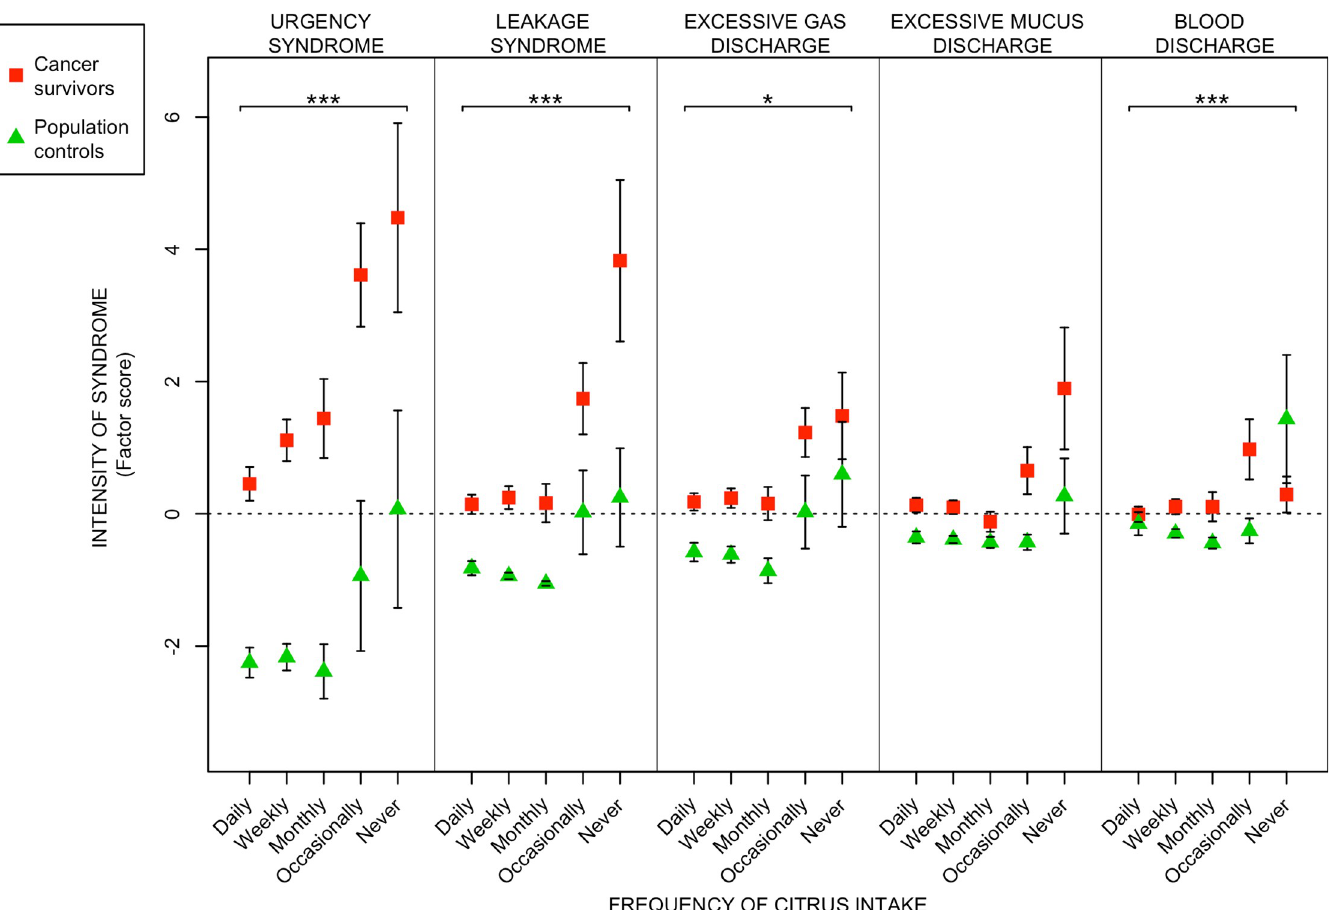
Fig 1. Relationships between radiation-induced survivorship syndromes and frequency of citrus intake. The figure depicts the relationships between frequency of citrus intake (x-axis) and intensities (factor scores) of the five radiation induced syndromes (y-axis: defecation-urgency syndrome, fecal-leakage syndrome, excessive gas discharge, excessive mucus discharge and blood discharge) among long-term gynecological cancer survivors and population controls. Red squares and green triangles denote the mean syndrome intensities within certain citrus intake frequency levels. Vertical black lines stretch between plus-minus the standard error of the mean. Asterisks correspond to significance levels of the Spearman correlations between syndrome intensities and frequency of citrus intake according to: p � 0.001 - ��� , 0.001 < p � 0.01 - �� . 0.01 < p � 0.05 - � . Estimates of the Spearman correlations are found in Tables 2 and 3.